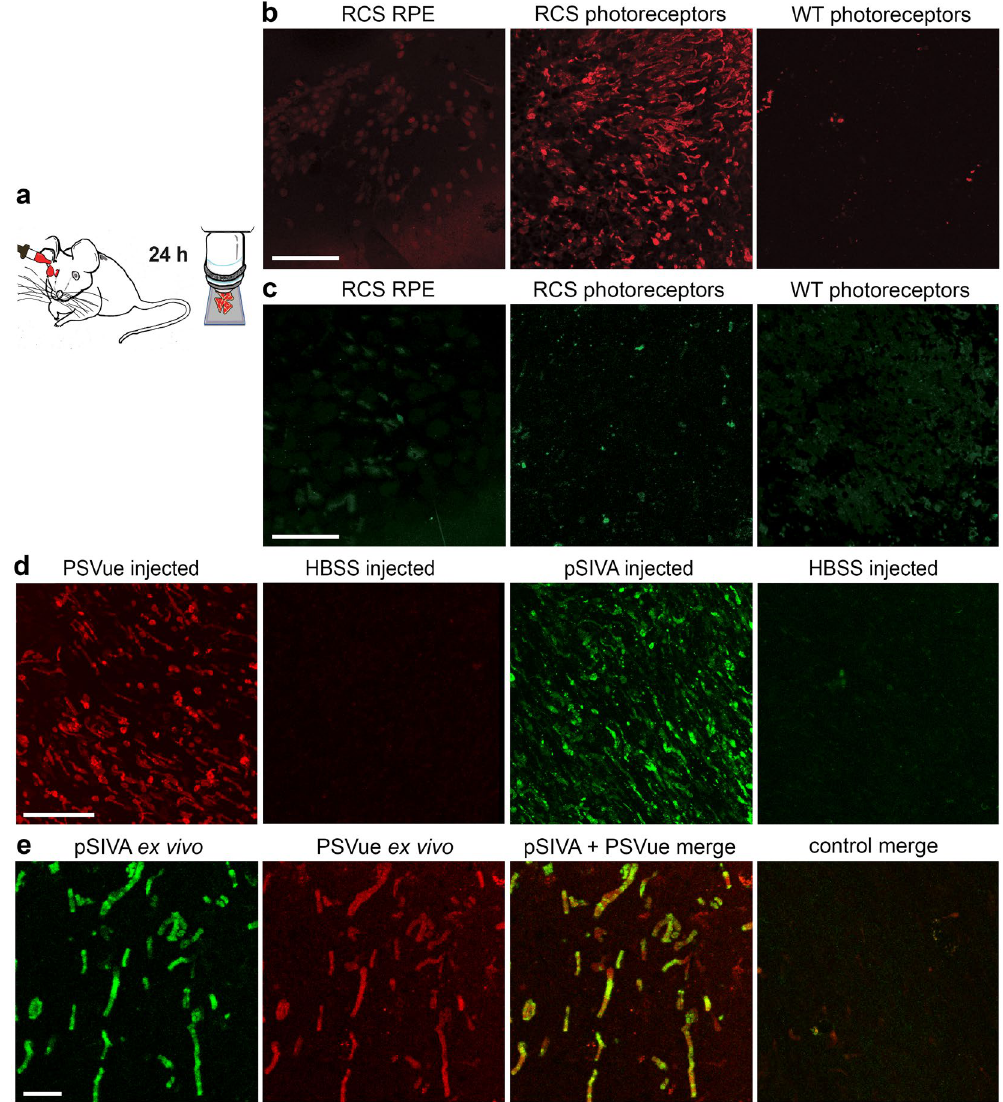
Figure 1. Comparison of staining of apoptotic photoreceptors by fluorescent PS probes PSVue-550 and pSIVA applied as eyedrop, by intravitreal injection, or to retina ex vivo . ( a ) Experimental paradigm for eyedrop probe application. ( b , c ) Representative maximal projection images of live dissected retina or RPE, as indicated, of PSVue-550 ( b ) or pSIVA ( c ) staining of p25 RCS or WT rat tissues as indicated. Tissues of equal volumes were imaged live immediately following dissection 24 hours after eye drop application as in a . Scale bar, 50 μ m. ( d ) Representative images of live dissected retina after PSVue-550 or pSIVA intravitreal injection. Images from control eyes injected with HBSS buffer are also shown to the right of each fluorescent probe, as indicated. Scale bar, 20 μ m. ( e ) Representative live imaging of co-staining by PSVue-550 and pSIVA probes following application of mixed probes to freshly dissected RCS rat retina ex vivo . Scale bar, 10 μ m. All retina flatmounts are shown photoreceptor side